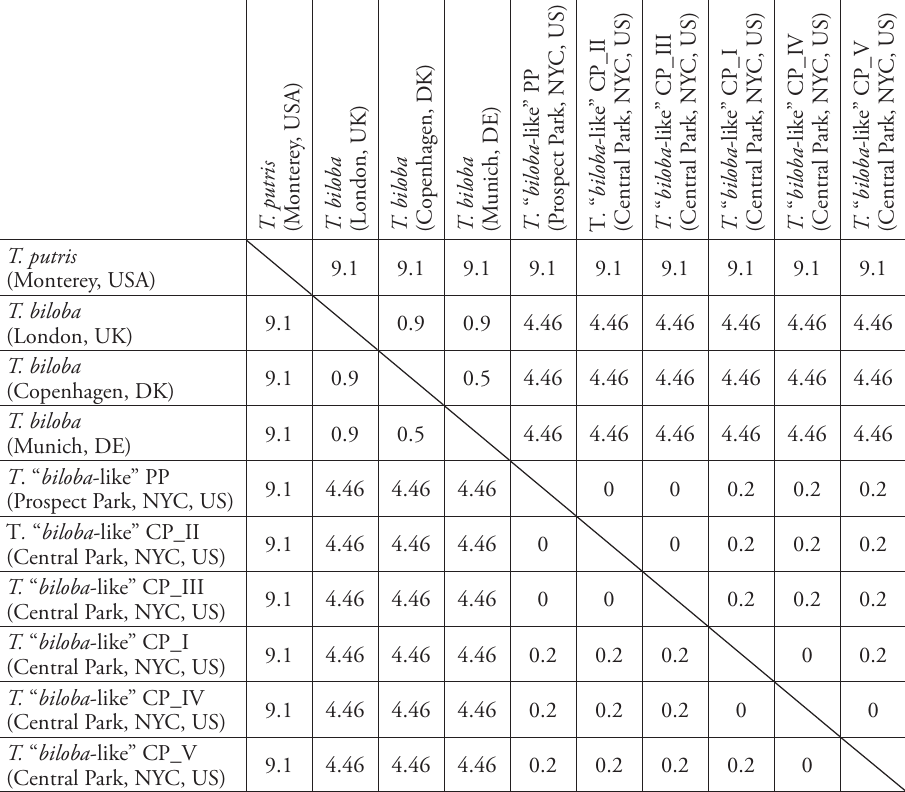
Table 2. COI barcode sequence pairwise differences for Themira “ biloba -like”, T. biloba, and T. putris specimens, based on SequenceMatrix. Numbers shown are in percentage